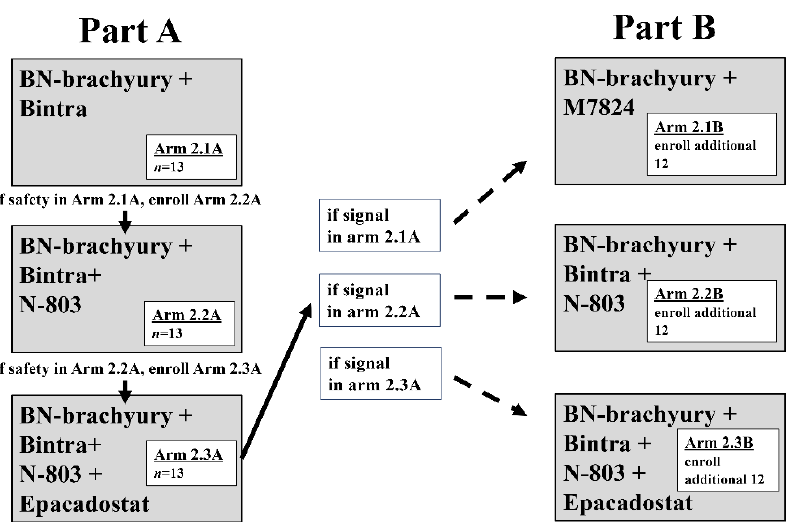
Figure 1. Quick efficacy seeking trial design trial schema. During part A, enrollment to arms 1.1 and 2.1A begins simultaneously. Arm 1.1 is a dose-finding arm for N-803 combined with Bintrafusp alfa (Bintra), open to all solid tumors. After arm 2.1A completes accrual and safety of the combination has been demonstrated, and N-803 dosing has been determined from arm 1.1, arm 2.2A begins accrual. After arm 2.2A completes accrual and safety of the combination has been demonstrated, enrollment to arm 2.3A begins. Each of the 3 arms enrolls a total of 13 patients during part A. At the completion of part A, if there is a positive safety signal and a positive efficacy signal in arm 2.1A, 2.2A, or 2.3A, part B will begin. To further assess efficacy, arms in which an activity signal was observed (arms 2.1B, 2.2B, and/or 2.3B) may expand to a total of 25 patients. During part B, patients are randomized among all open arms to avoid selection bias.